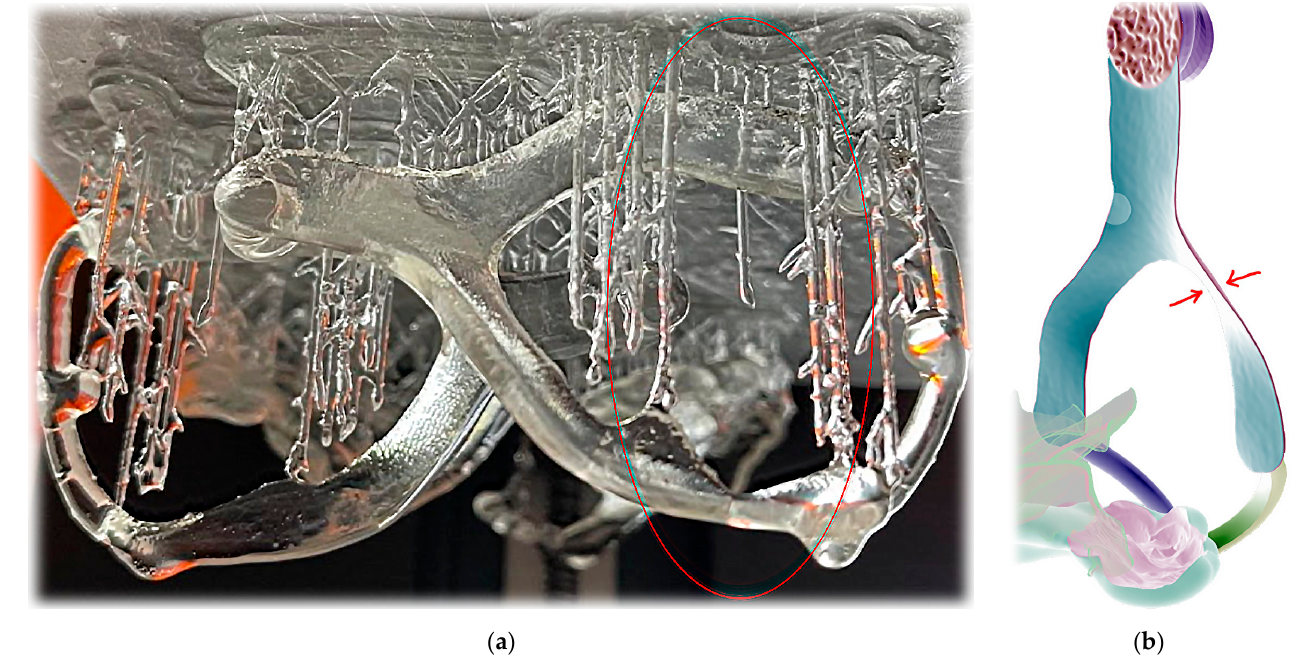
Figure A2. Extraoral part additive manufacturing failures: ( a ) example of failure where extreme thinness on extraoral part resulted in material buildup drop; ( b ) extreme thinness and not ideal object positioning in this part led to failure of Dental LT Clear V2 (Formlabs) 3D printing.